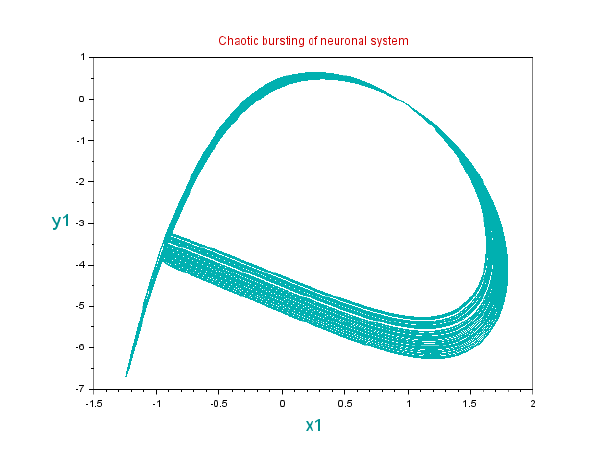
Figure 3. Chaotic attractors of the HR system: x 1 x 2 − plane